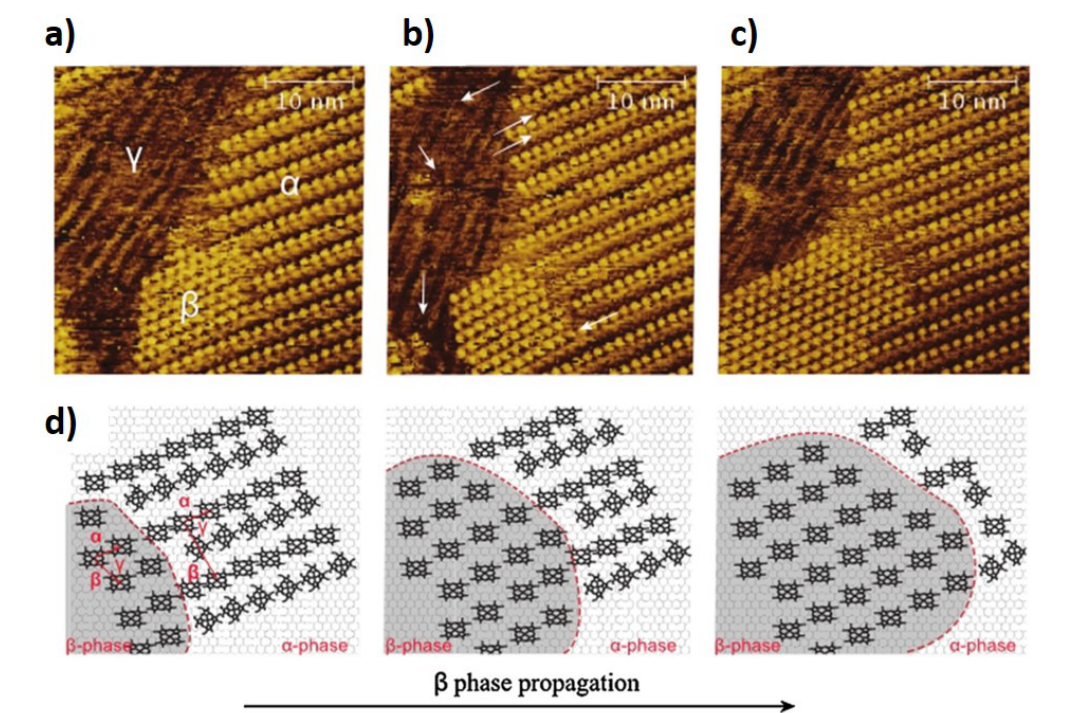
Figure 2. STM images ( a – c ) of ZnOEP adsorption on highly oriented pyrolytic graphite (HOPG) were recorded sequentially with 2-min intervals, starting 2 h after the deposition of porphyrin in the tetradecane droplet. These STM images show a polymorphic monolayer with three different co-existing phases, in which the white arrows point to molecules with increased contribution to the signal and a propagation of a β -phase, which is modelled in ( d ). (Reprinted with permission from reference [17]. Copyright 2013 Elsevier